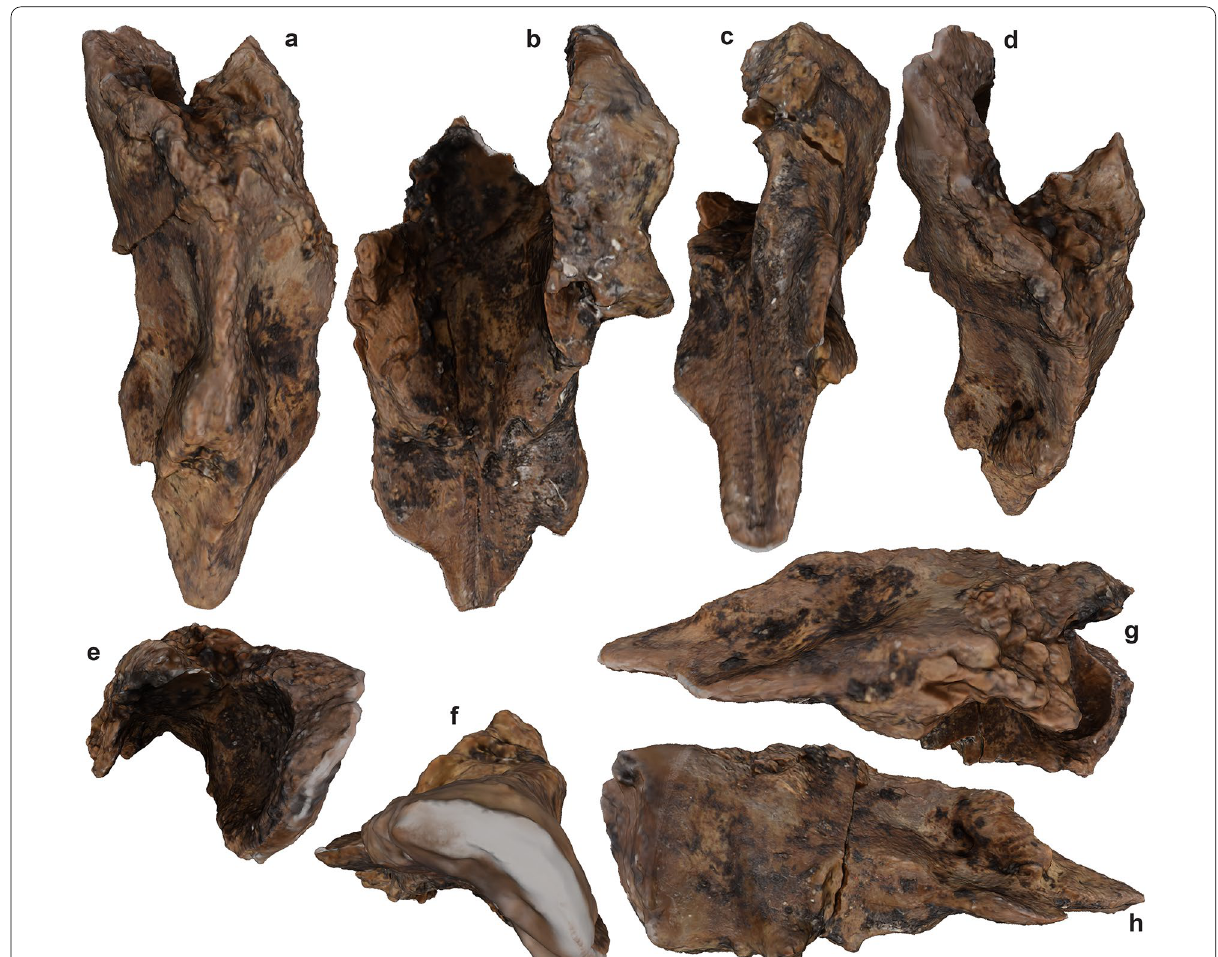
Fig. 70 Eoconstrictor spinifer comb. nov. from quarry Cecilie I, Geiseltal—part of the lectotype (herein designated): 3D models of the parietal (GMH Ce I-5823-1926) in dorsal ( a ), ventral ( b ), posteroventral ( c ), anterodorsolateral ( d ), anterior ( e ), posterior ( f ), right lateral ( g ), and left lateral ( h ) views. Images not to the same